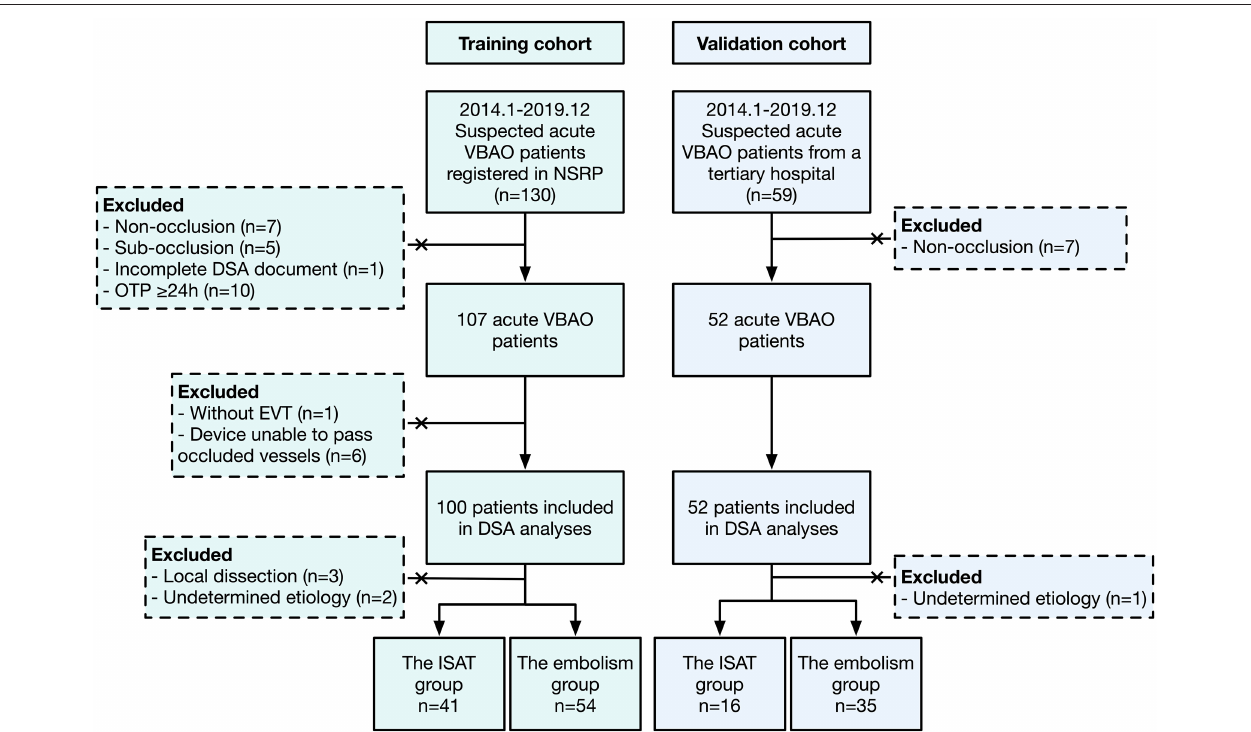
FIGURE 1 | The flowchart of this study. VBAO, vertebrobasilar artery occlusion; NSRP, Nanjing Stroke Registry Program; DSA, digital subtraction angiography; OTP, onset to puncture; EVT, endovascular treatment; ISAT, in situ atherosclerotic thrombosis.